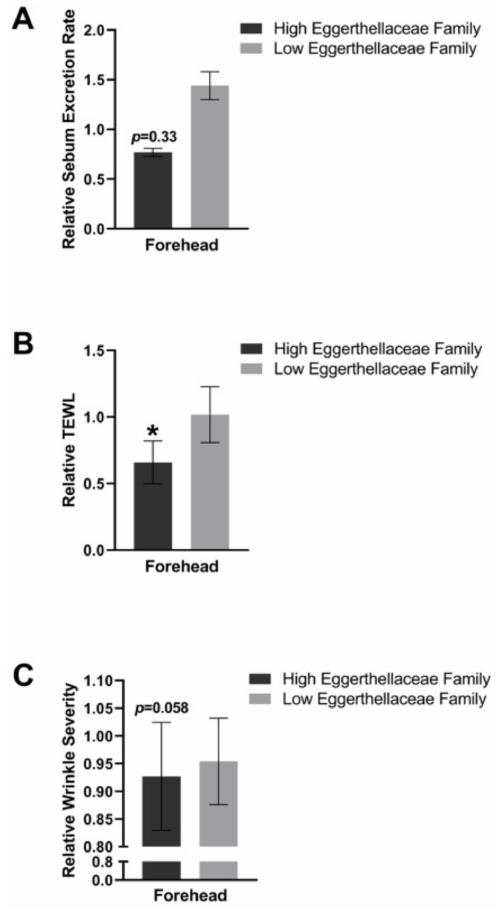
Figure 6. Sub-analysis based on high expression of Eggerthellaceae in the gut. The participants in the PE group were stratified as high or low expression of Eggerthellaceae in the gut and the influence on sebum excretion rate ( A ), TEWL ( B ), and wrinkle severity ( C ) are depicted. * = p <